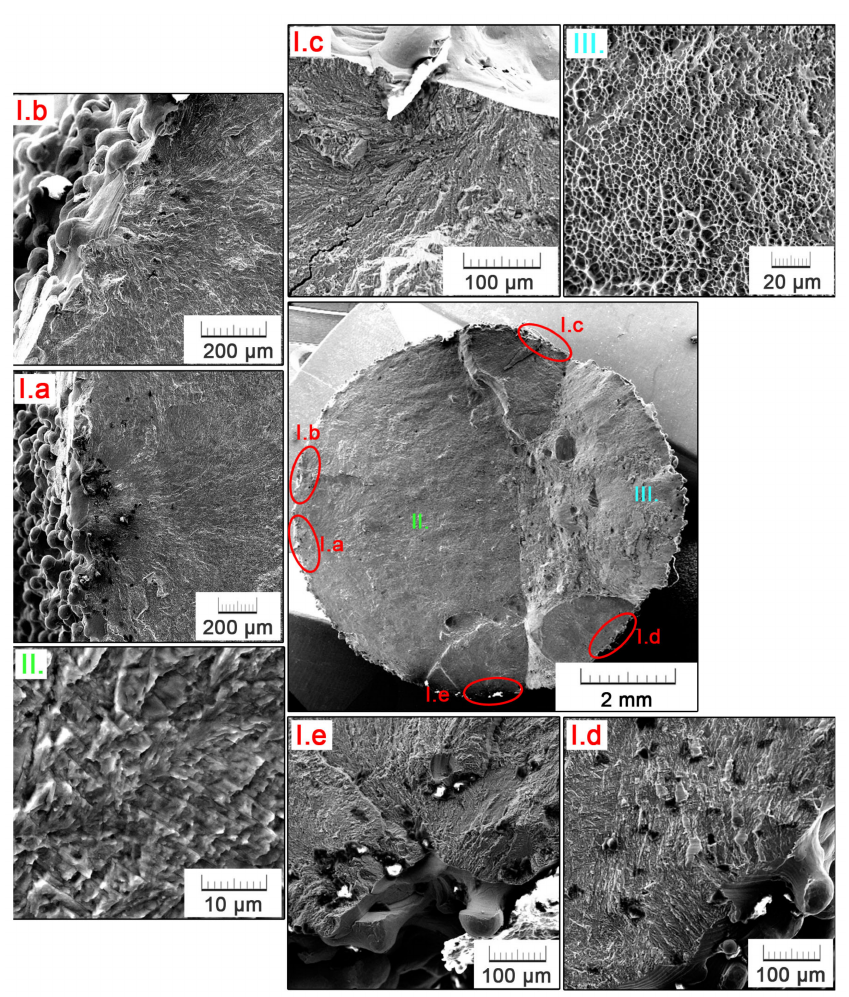
Figure 8. Details of crack initiation sites ( I.a – e ), crack propagation ( II .) and final fracture ( III .) areas on the fracture surface of the EBM fatigue specimen.